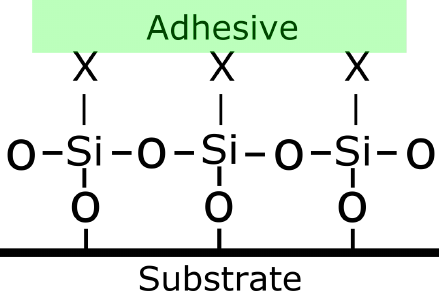
Figure 10. Interaction between a silane coupling agent and the metal